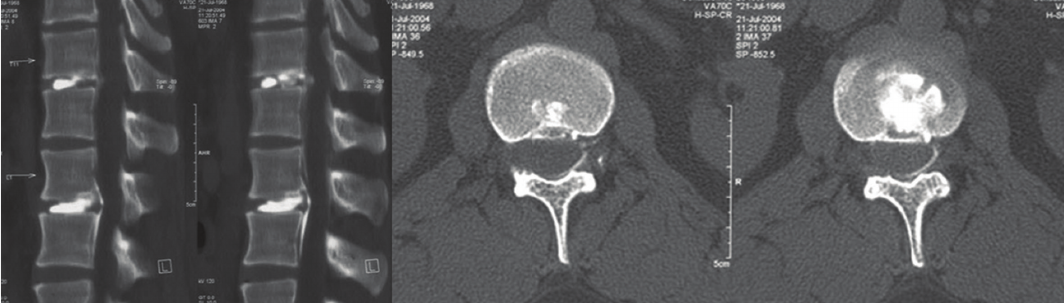
Figure 1: Provocative discography shows degeneration of the disc.